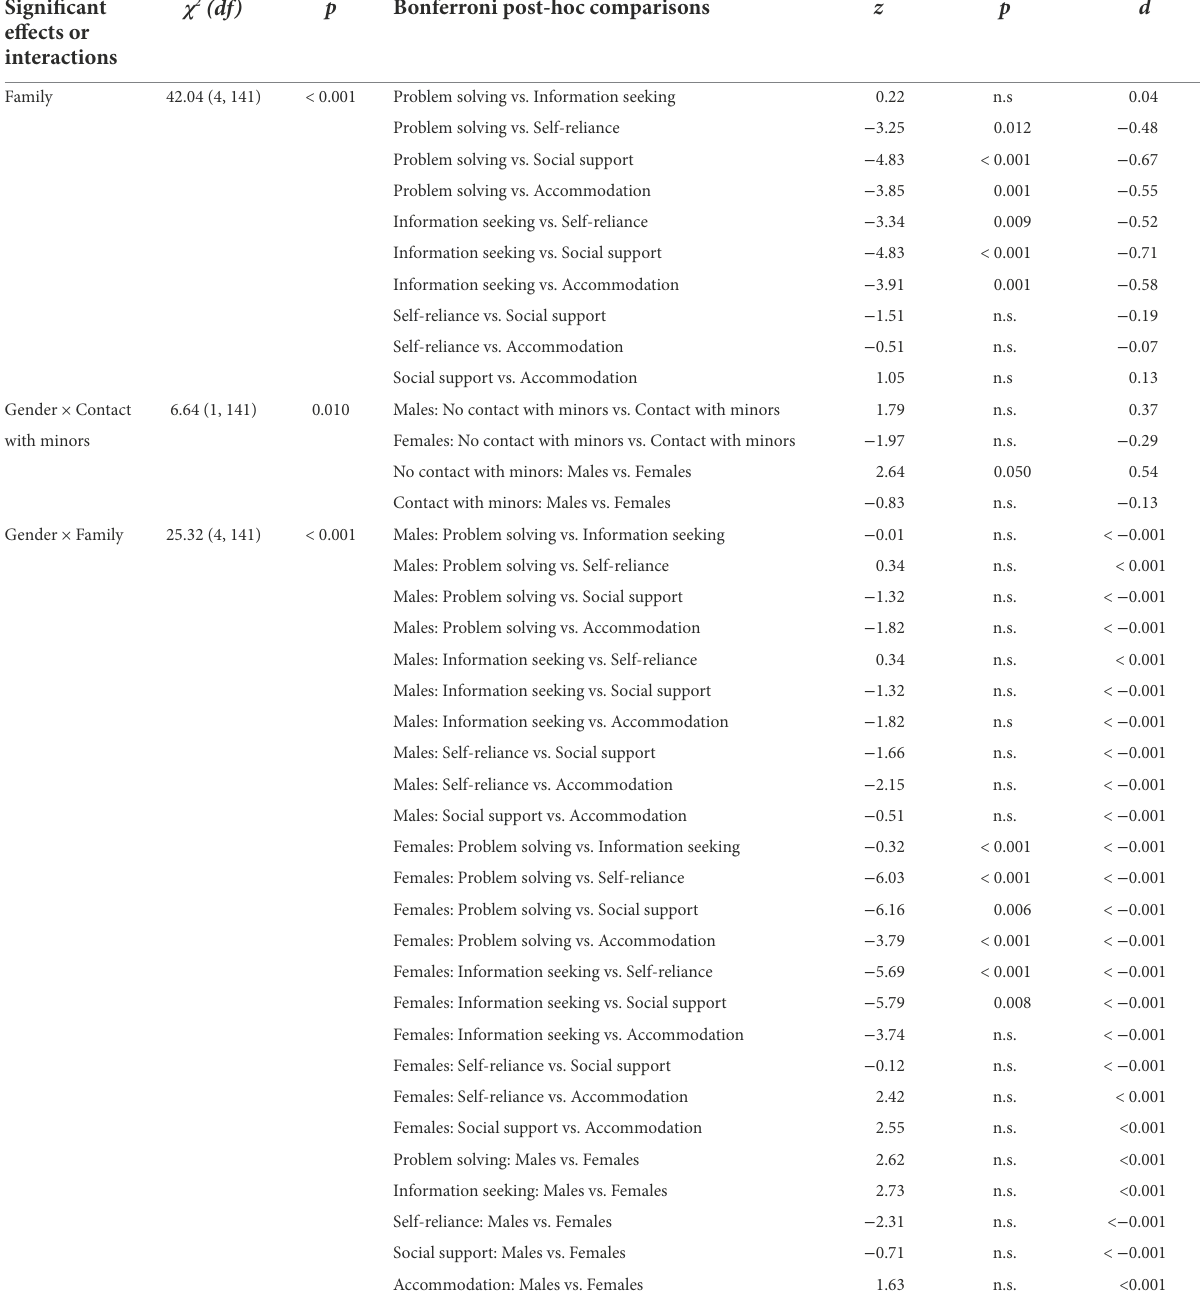
TABLE 3 Chi square (with degrees of freedom) and level of significance for significant effects and interactions, and key Bonferroni tests and effect sizes, for the GLMM for the survey about the families of coping strategies concerning the news about wars. Significant effects